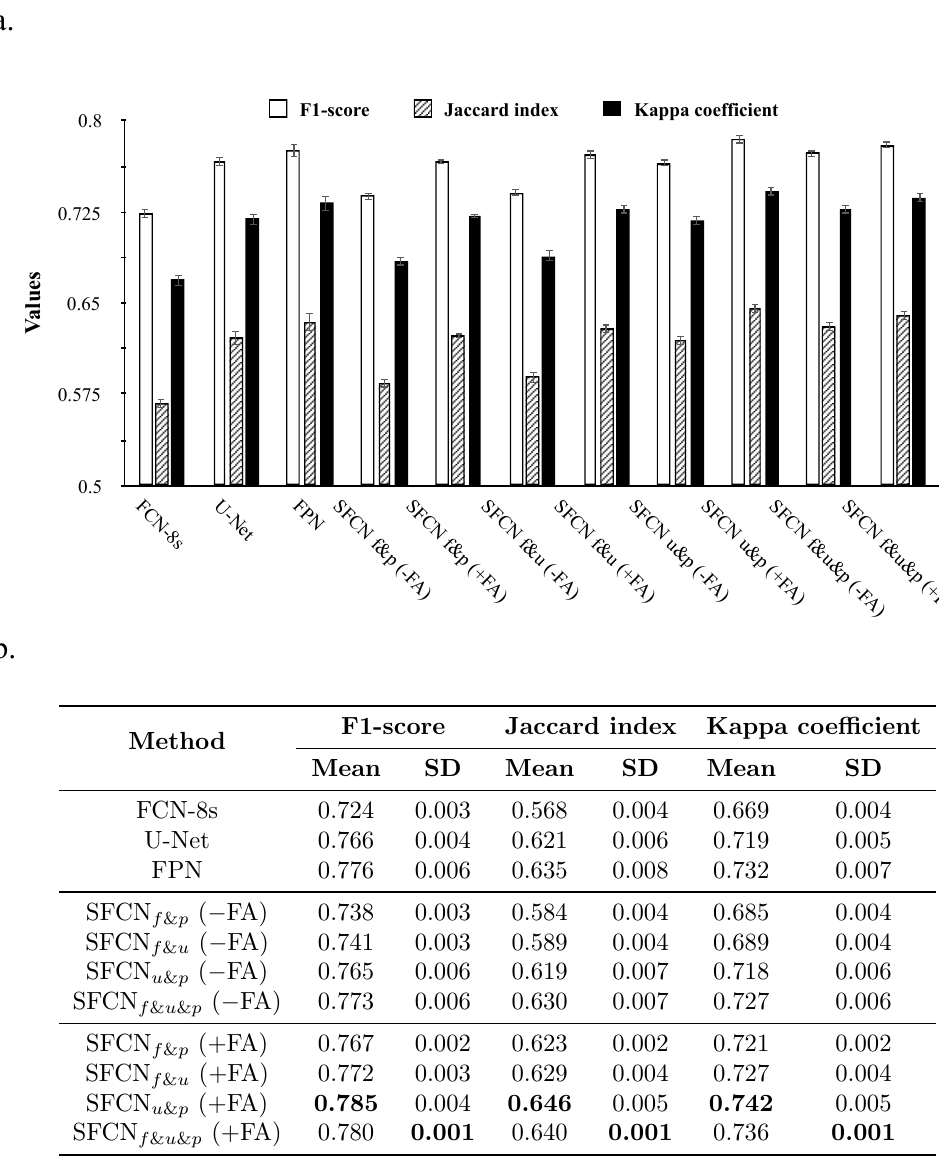
Figure 6. Comparison of performances of the basic models of FCN-8s, U-Net, and FPN as well as four SFCNs with/without feature alignment. ( a ) Bar chart for comparison of relative performances. ( b ) Table of mean value and standard deviation (SD) of the performance comparison of these methods. For each evaluation metric, the highest mean values and lowest SD are highlighted in bold